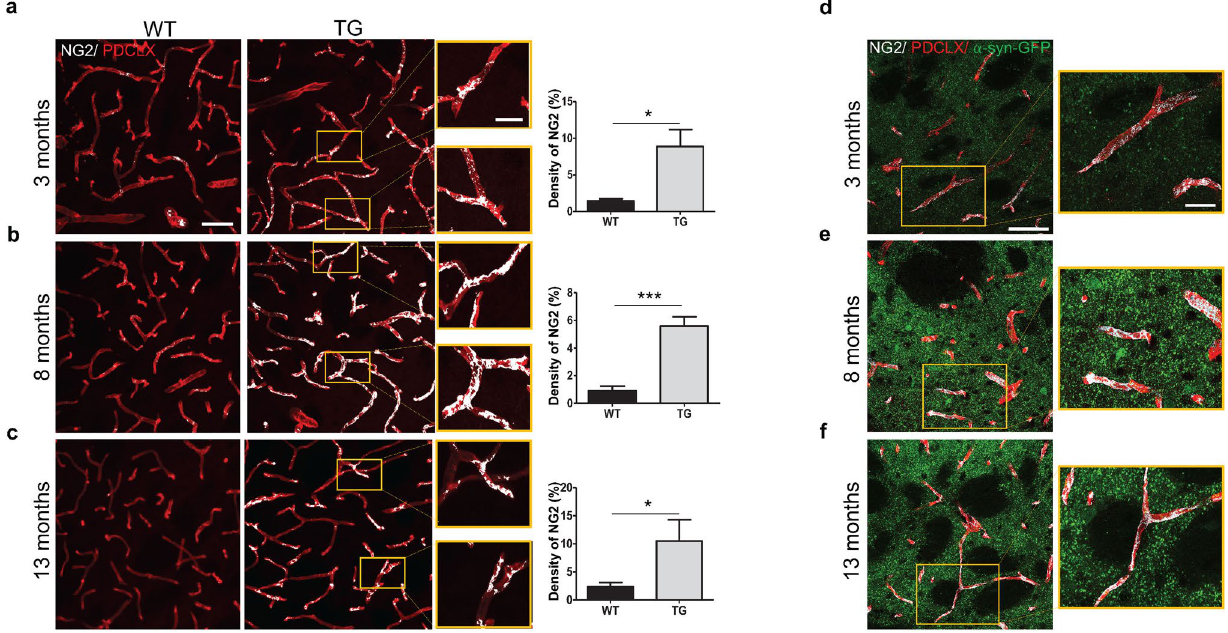
Figure 7. Activated NG2 + pericytes in the striatum of TG mice. Confocal images showing NG2 + pericyte coverage (grey) of PDCLX + vessels (red) in WT and TG mice and quantification of NG2 + pericyte density at ( a ) age of 3 months (n = 3 WT, 3 TG); ( b ) age of 8 months (n = 4 WT, 3 TG); and ( c ) age of 13 months (n = 4 WT, 4 TG). Confocal images showing NG2 + pericyte coverage (grey) of PDCLX + vessels with α -syn-GFP in TG mice at age of 3 ( d ), 8 ( e ) and 13 ( f ) months. Two-tailed student’s t-test: *p-value < 0.05, ***p-value < 0.001. Scale bar: large image ( a–f ) 50 μm; image box ( a–f ) 20 μm. PDCLX = Podocalyxin, NG2 = Neuron-glial antigen 2, α-syn- GFP = alpha-synuclein green fluorescent